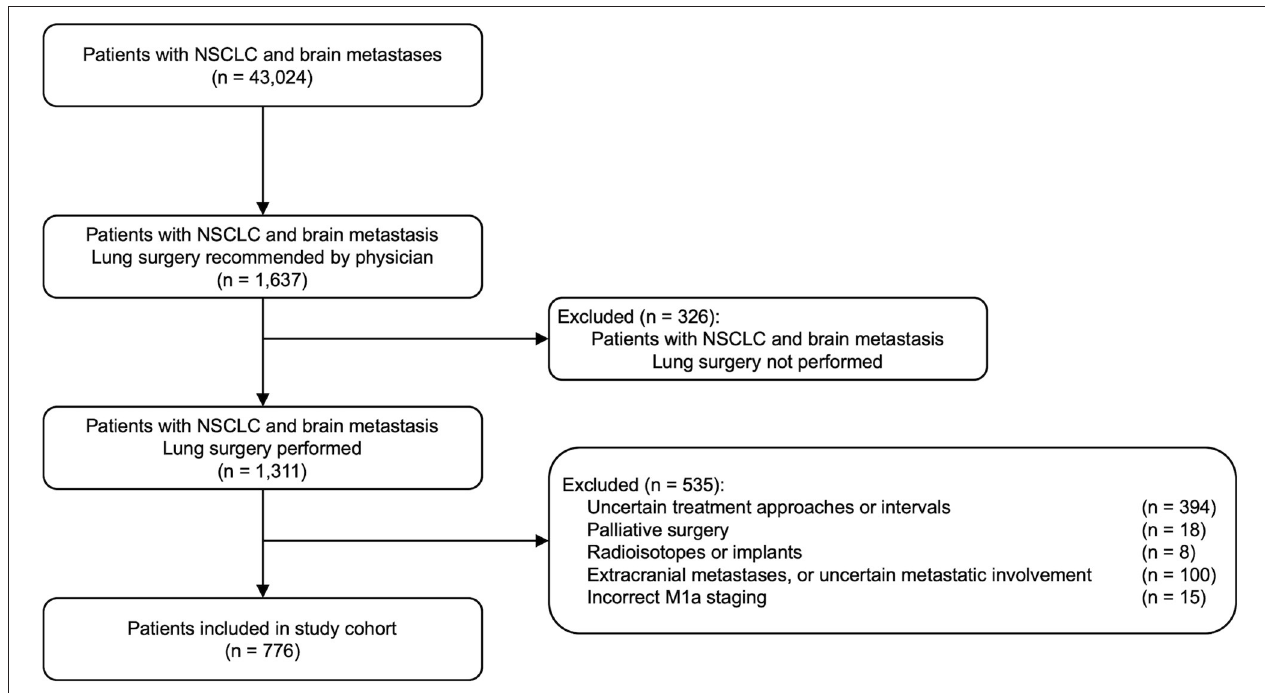
FIGURE 1 | Patient cohort selection.